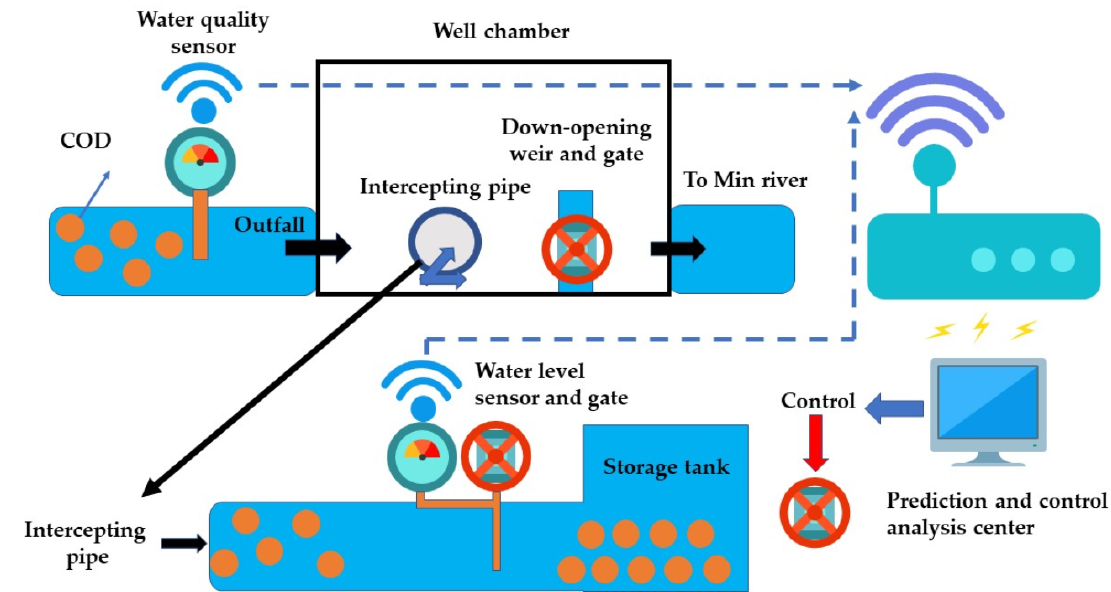
Figure 10. The schematic drawing of double-gate scheme.